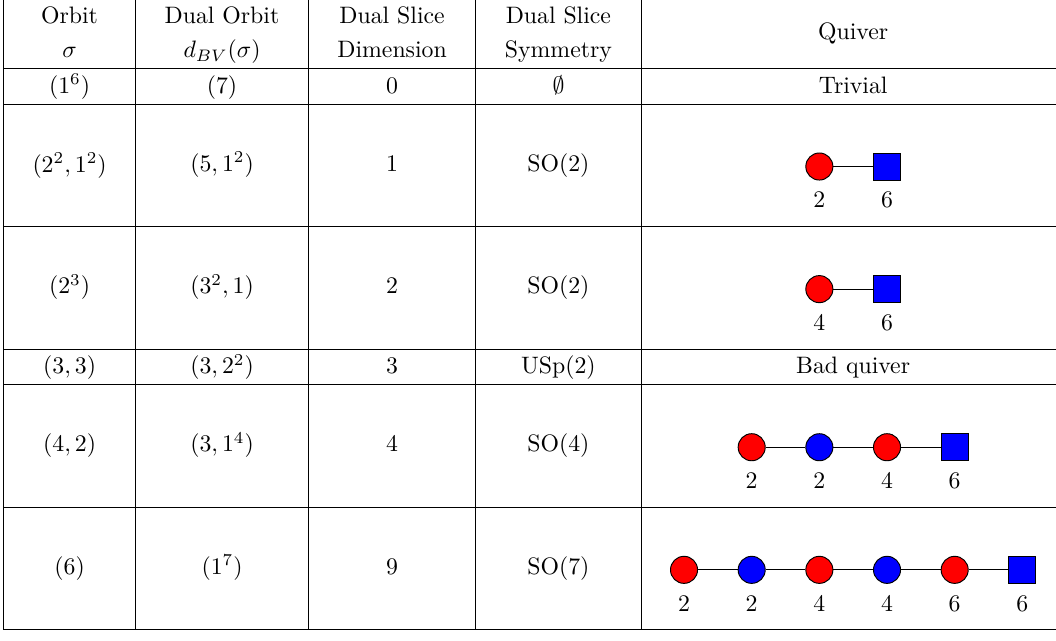
Table 21. T (USp(6)) linear quivers. These are used in twisted A 5 fixtures. The